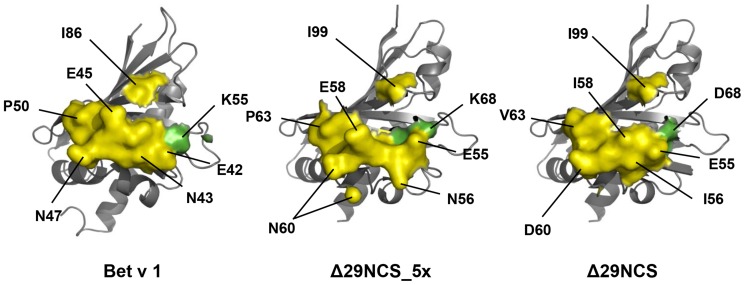
Grafting of an epitope onto Δ29NCS.Left panel: 13 of the 16 amino acids comprising the Bet v 1 epitope (Bet v 1E42/N43/I44/E45/G46/N47/G48/G49/P50/G51/T52/R70/D72/H76/I86/K97) of mouse monoclonal IgG antibody BV16 (yellow). Six amino acids of the epitope are labeled. Lys55 of Bet v 1 located adjacent to the epitope is highlighted (green). Middle panel: the corresponding 13 residues of the Bet v 1 epitope for BV16 and a lysine corresponding to K55 of Bet v 1 have been grafted onto Δ29NCS to generate Δ29NCS_4x (Δ29NCS N57/I58E/D60N/V63P) (not shown) and Δ29NCS_5x (Δ29NCS N57/I58E/D60N/V63P/D68K). Right panel: corresponding surface area of Δ29NCS. Protein models were based on the structures of NCS (pdb 2VNE) and Bet v 1a (pdb 1BV1), and modelled with a confidence of 100% and a sequence coverage of at least 85%.